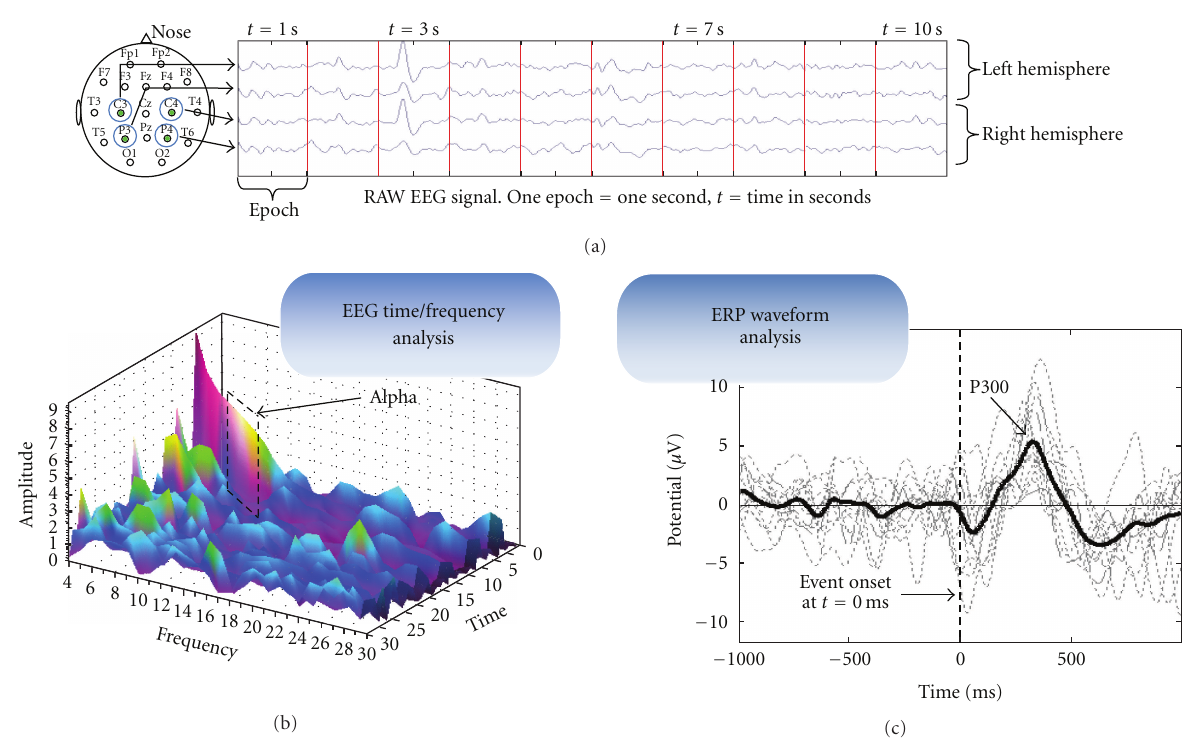
Figure 1: Snapshot of a 10 seconds EEG raw data analyzed using two main